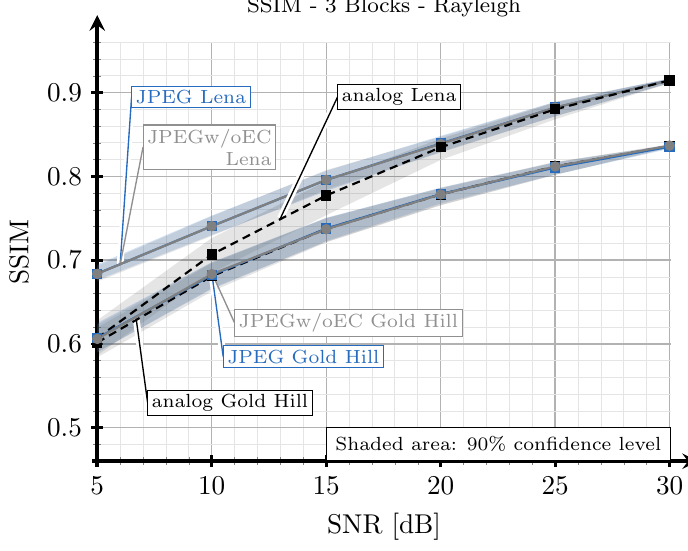
Figure 18. SSIM vs. SNR for three blocks and Rayleigh